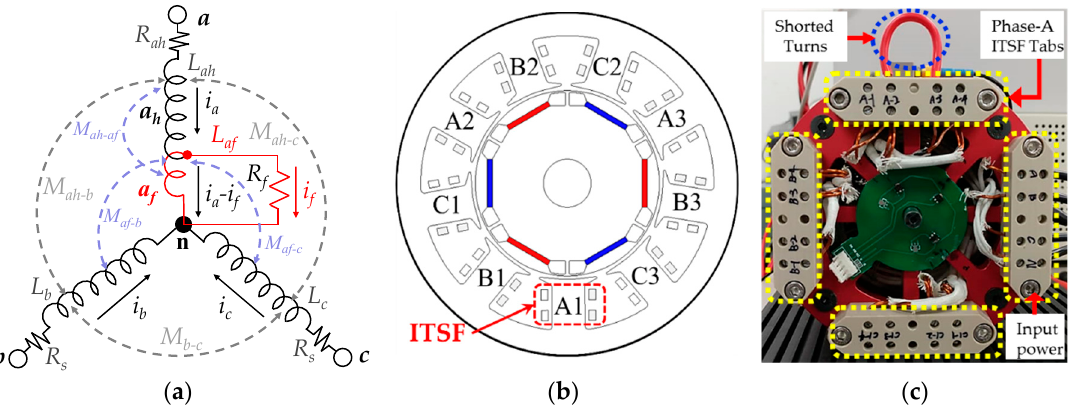
Figure 1. IPMSM with ITSF in Phase-A. ( a ) Equivalent circuit of three-phase IPMSM with ITSF in Phase-A; ( b ) FEM model of a 400-watt IPMSM with shorted turns in the A1 tooth of phase-A; ( c ) 400-watt IPMSM with ITSF tabs.